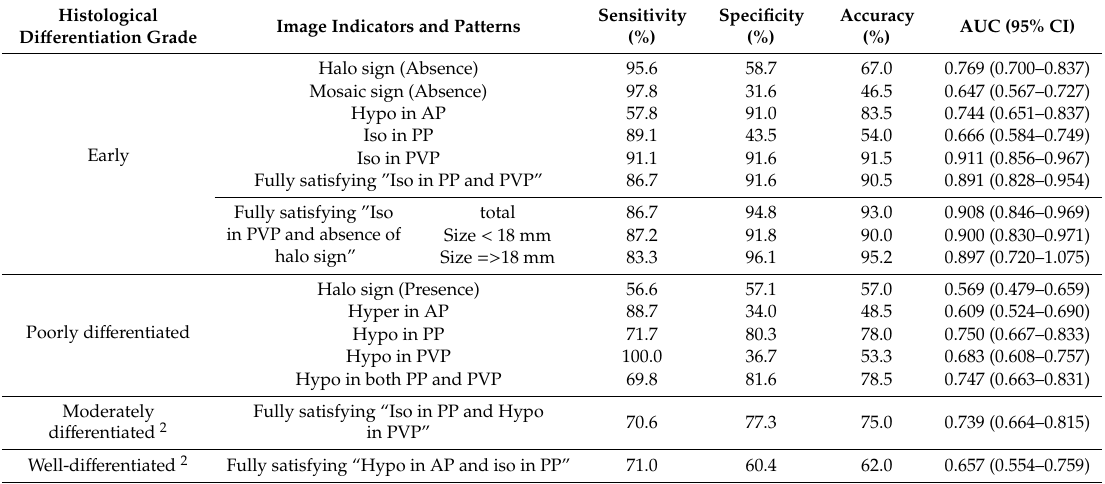
Table 4. Diagnostic e ffi cacy for di ff erent histological di ff erentiation grades of HCC 1